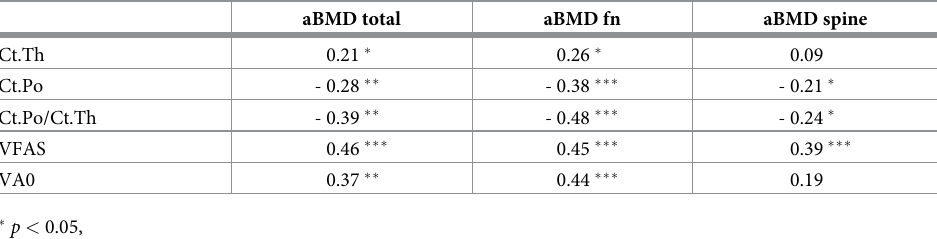
Table 3. Spearman’s correlation coefficients R between BDAT and DXA parameters and the second population (87 patients). aBMD